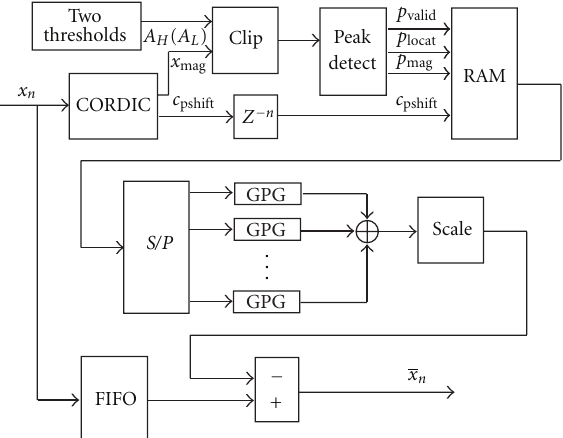
Figure 6: High-level FPGA implementation of the proposed approach.